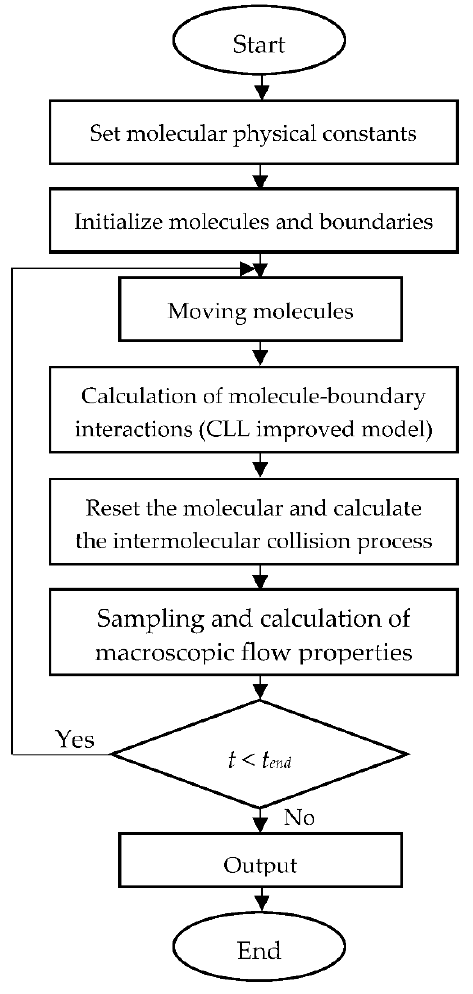
Figure 4. DSMC simulation flow chart.